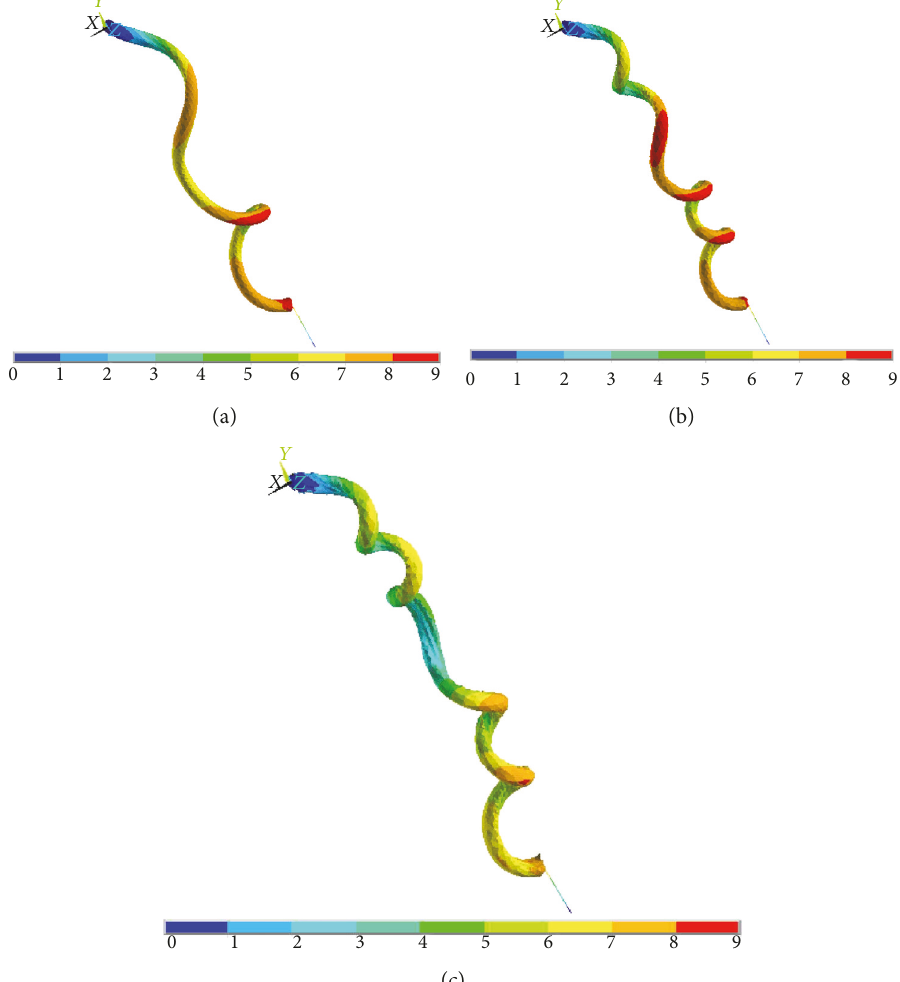
Figure 6: Free coiling of the entire tendril model, exemplifying total displacement plots: at (a) 32%, (b) 52%, and (c) the fi nal stage. The underlying color bar indicates the overall displacements, in